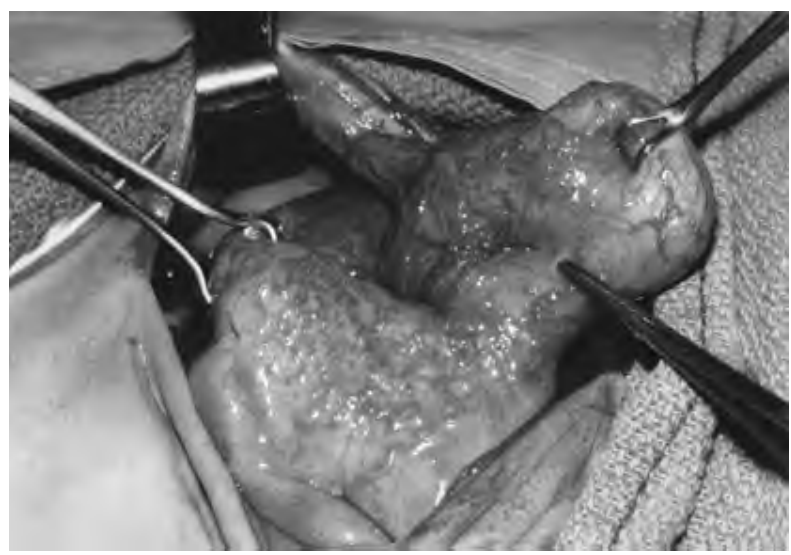
FIGURE 2. Gross presentation of the bladder demonstrating bladder diverticulum and urachus.